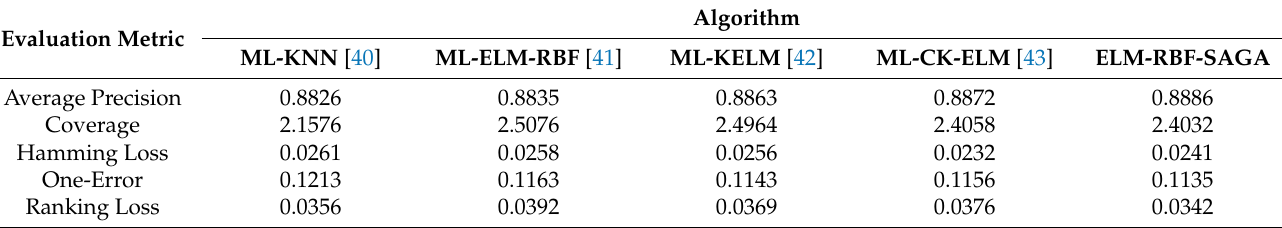
Table 7. Performance of different models in the business dataset.